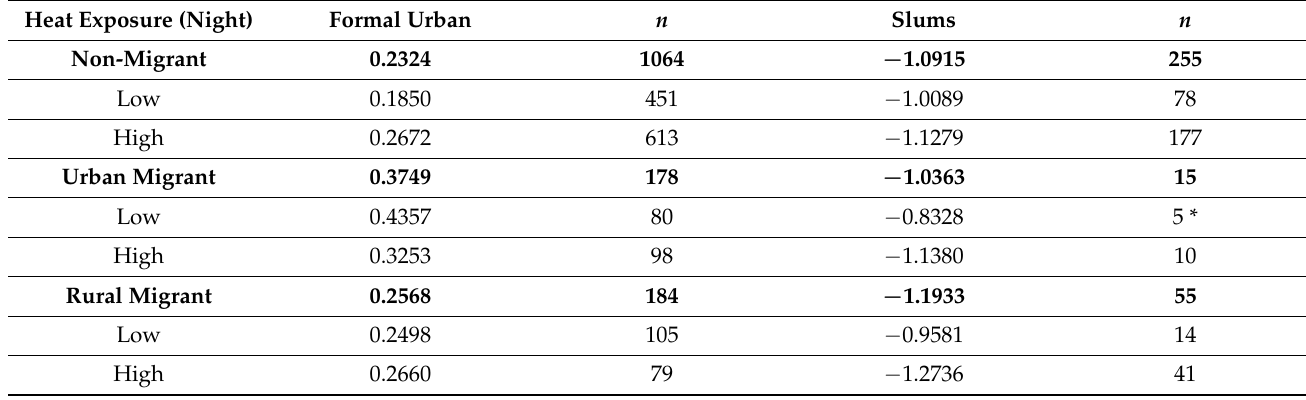
Figure 11. Resilience matrix displaying kernel density estimation of RCI of sub-groups based on the migration characteristic environmental exposure, displaying heat exposure. Table 7. RCI of sub-groups based on the migration characteristic environmental exposure, displaying heat exposure (night; * low sample